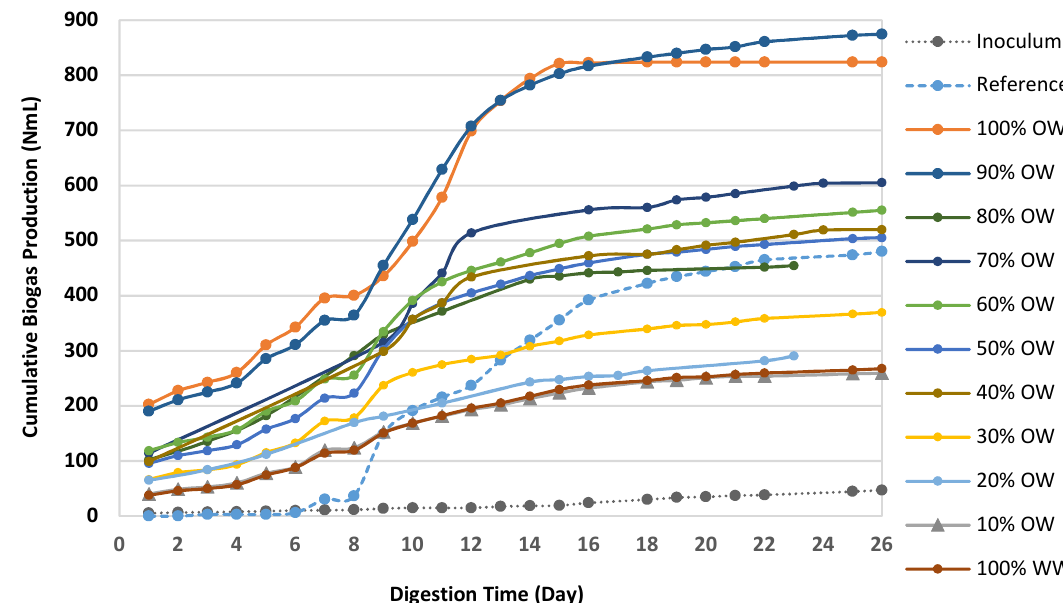
Figure 2. The cumulative biogas production volumes per gram of VS (total volumes were recorded in the climate room system, then divided by the VS